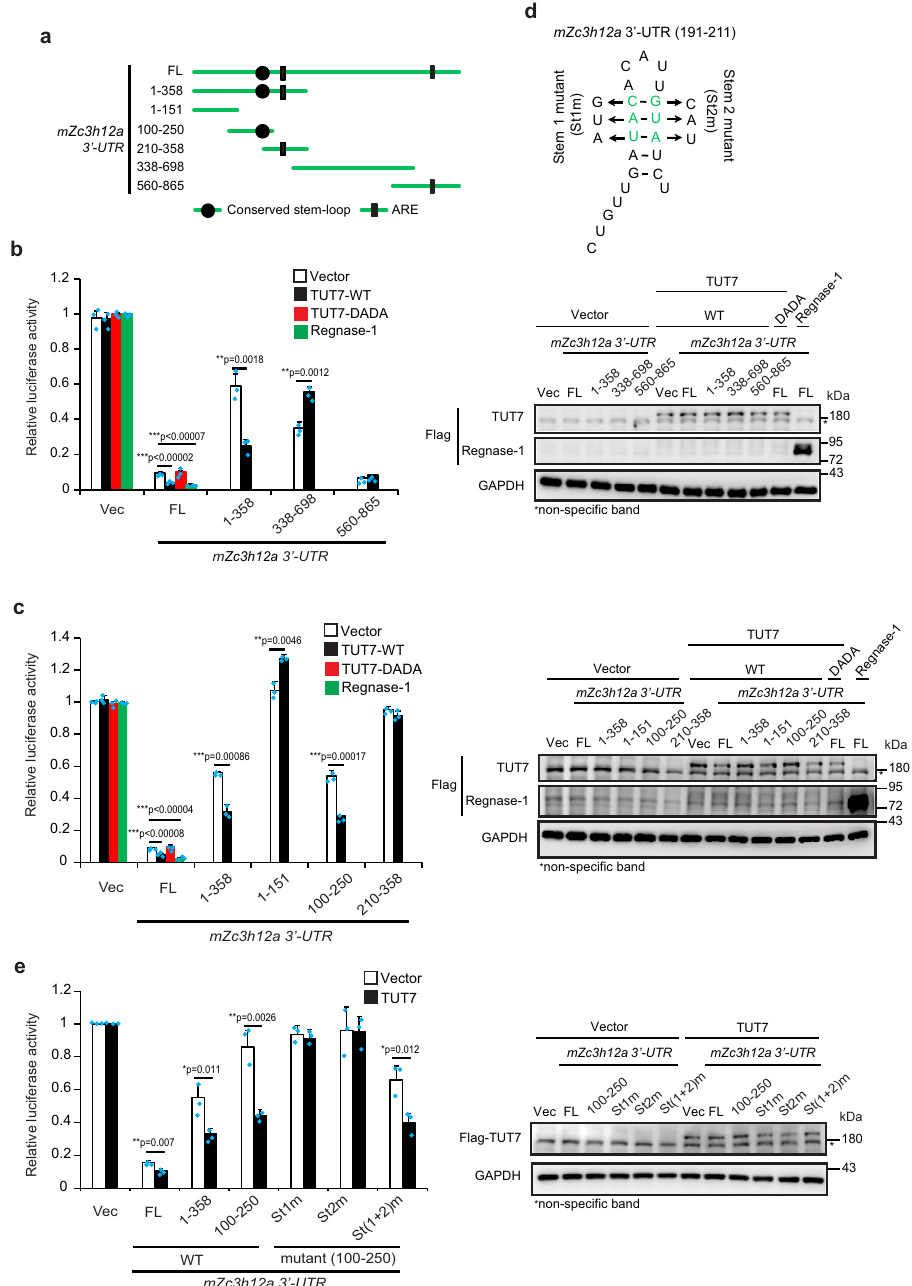
Fig. 4 TUT7 modulates Zc3h12a mRNA stability via its 3 ′ -UTR 100-250 . a Schematic diagram of the fi re fl y luciferase reporter constructs containing full- length (FL) and truncated forms of mouse Zc3h12a 3 ′ -UTR ( mZc3h12a 3 ′ -UTR ). b , c , e HEK 293 cells were co-transfected with wild-type TUT7 (TUT7-WT), enzymatic inactive TUT7 (TUT7-DADA), or Regnase-1 expression plasmids, the indicated fi re fl y luciferase reporter constructs containing various fragments of mZc3h12a 3 ′ -UTR as well as TK-renilla control reporter plasmid. At 48 h post-transfection, cells were harvested and the luciferase activities were determined. The expression of indicated proteins was con fi rmed by immunoblotting and is shown in the right panel. d Schematic diagram of the fi re fl y luciferase reporter constructs containing stem mutants (St1m and St2m) of mZc3h12a 3 ′ -UTR 100 – 250 . Mutant St(1 + 2)m was generated by swapping sequences on both stems in mZc3h12a 3 ′ -UTR. Mutations of the stem-loop structure of mZc3h12a 3 ′ -UTR 100 – 250 were predicted by ref. 11 . Data presented are representative of three independent experiments with triplicates in each experiment (error bars, mean ± S.D.). The p values were obtained from two- tailed Student ’ s t test and are shown in the fi gure if p < 0.05. Source data are provided as a Source Data fi